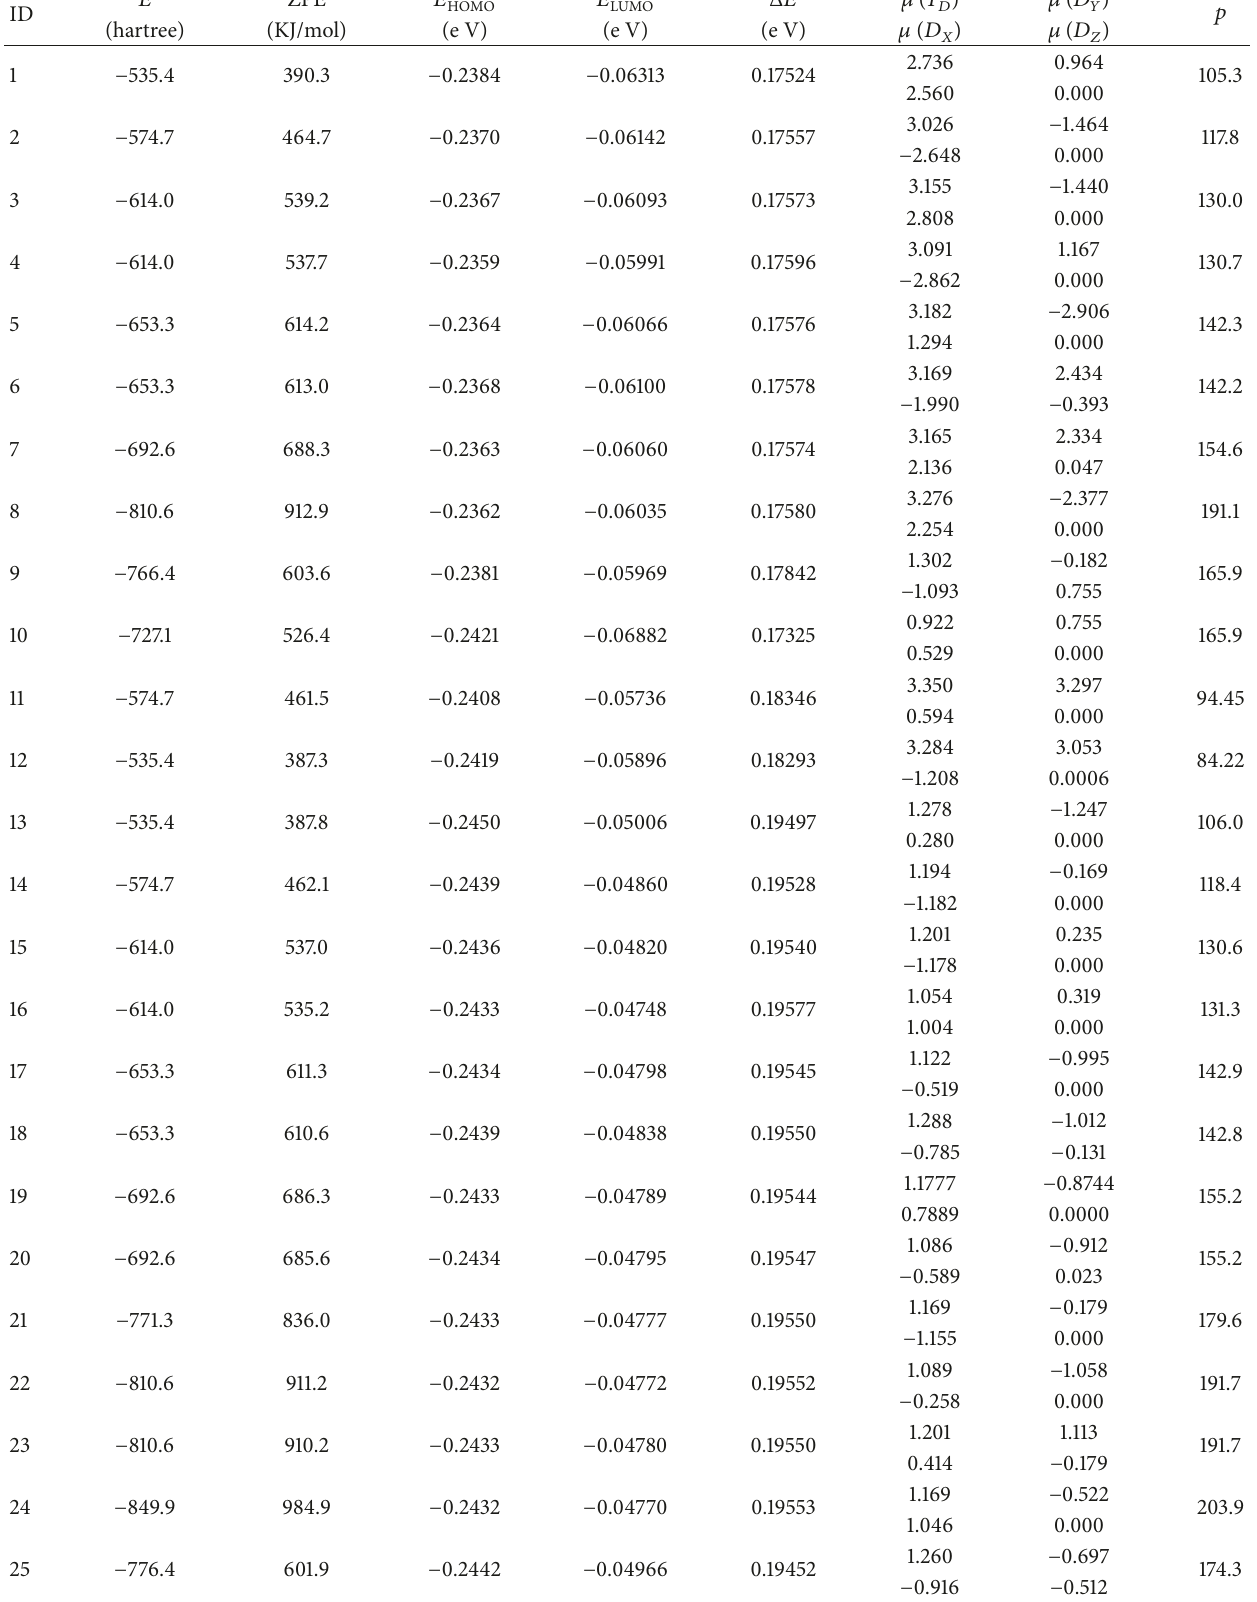
Table 3: Quantum chemical parameters of hydroxyl benzoic group at B3LYP/6-31G(d)